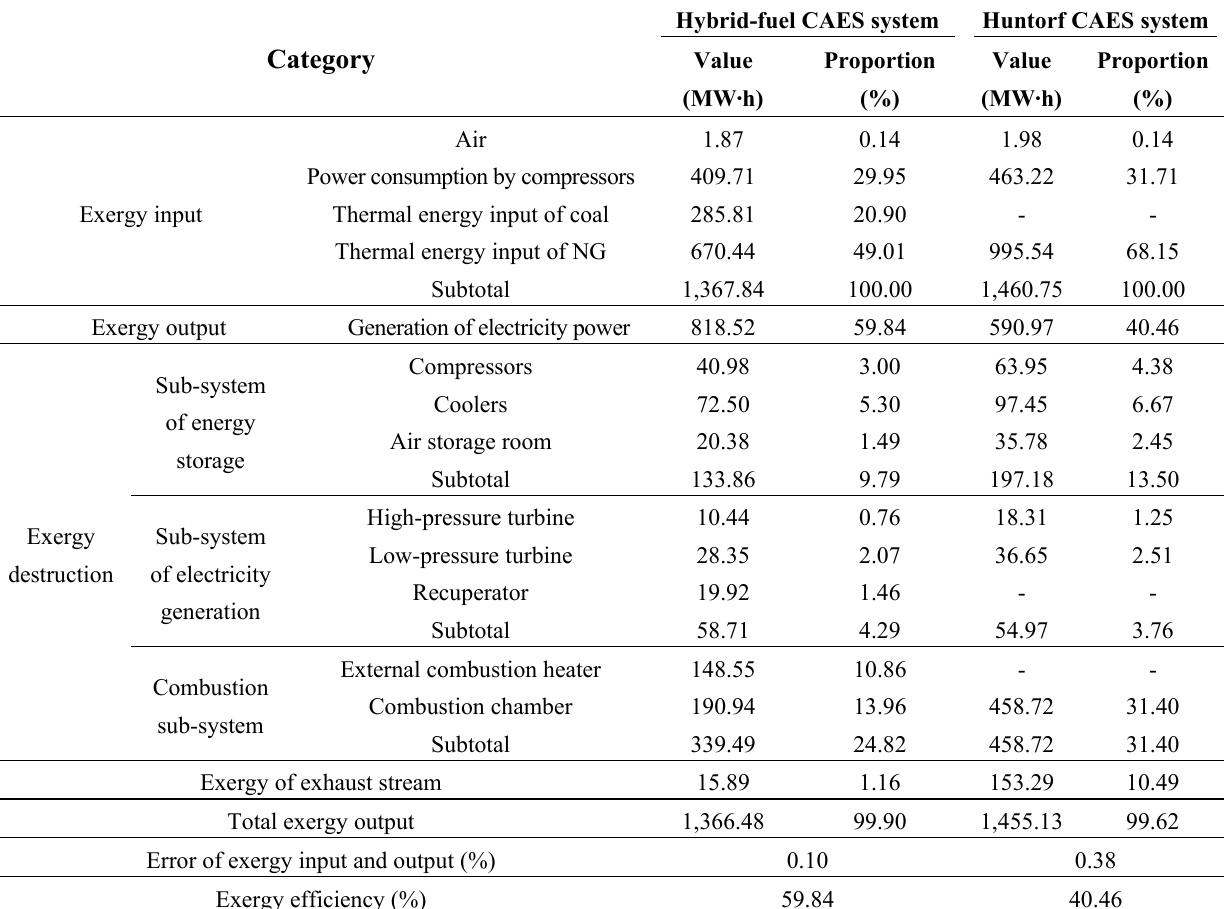
Table 6. Exergy analysis of the hybrid-fuel CAES system. Hybrid-fuel CAES system Huntorf CAES Category